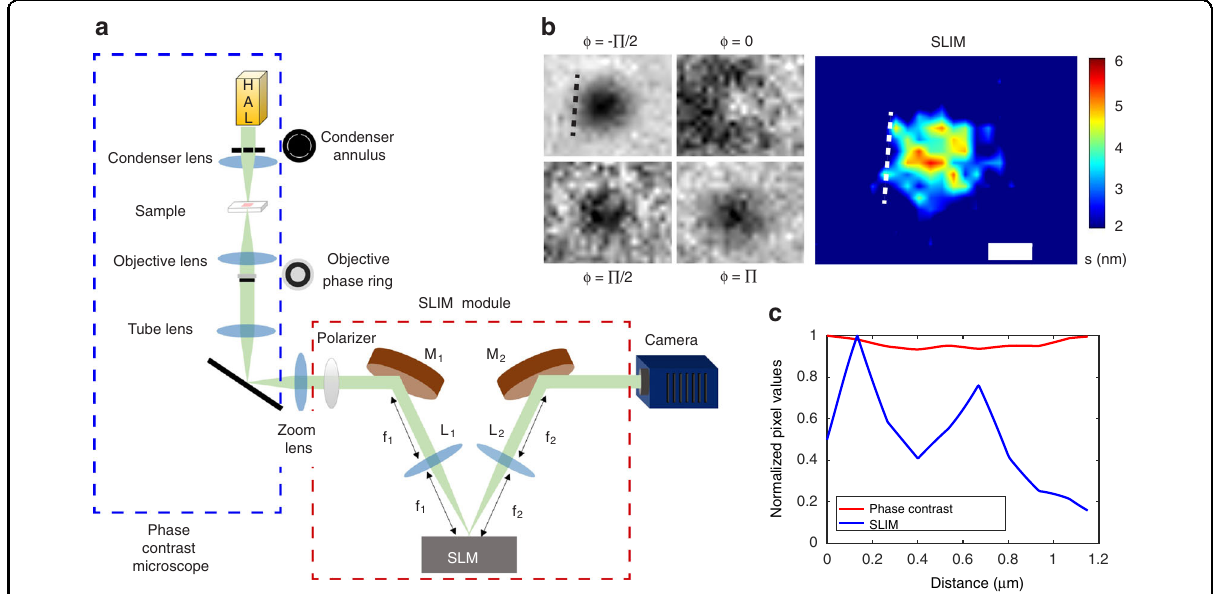
Fig. 2 SLIM. a Optical con fi guration of SLIM. b Image reconstruction, with color bar representing optical path length (s), in nm. c Pro fi le through yellow dotted line in b , showing high sensitivity of SLIM over phase